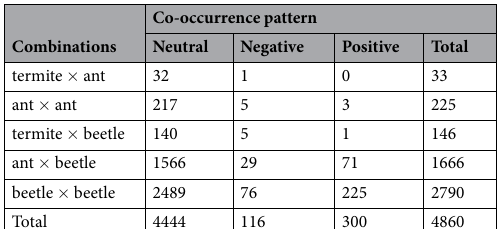
Table 4. Summary of results from co-occurrence analysis separated by various pair categories: termite × ant, ant × ant, termite × beetle, ant × beetle and beetle × beetle.